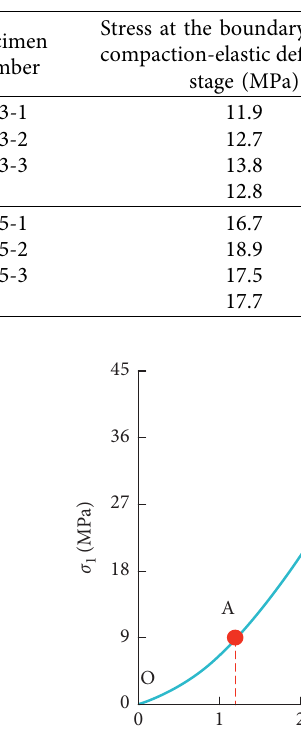
Table 2: Mechanical test results.